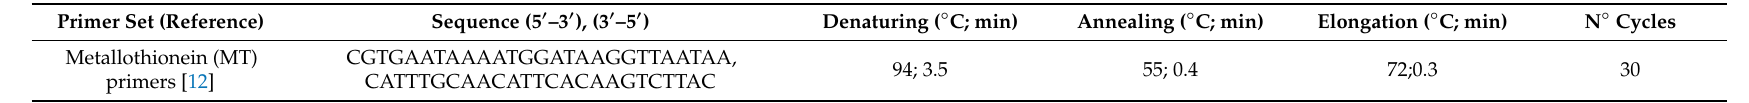
Table 1. Primer sequences, final concentrations and annealing temperatures for the primers used for measuring the degradation of DNA.